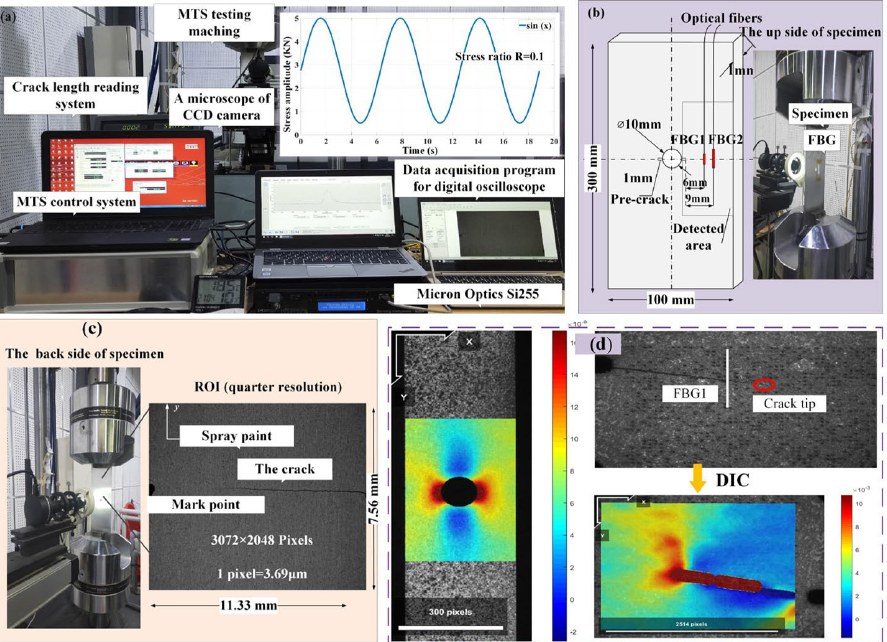
Figure 3. The FBG fatigue crack damage-monitoring test platform and the DIC processing method. ( a ) an experimental platform for fatigue detection of hole-edge crack damage; ( b ) the FBG sensor placement on the specimens; ( c ) an experimental platform for DIC measurement system; ( d ) the image processing techniques by the DIC method. Table 1. The parameters of